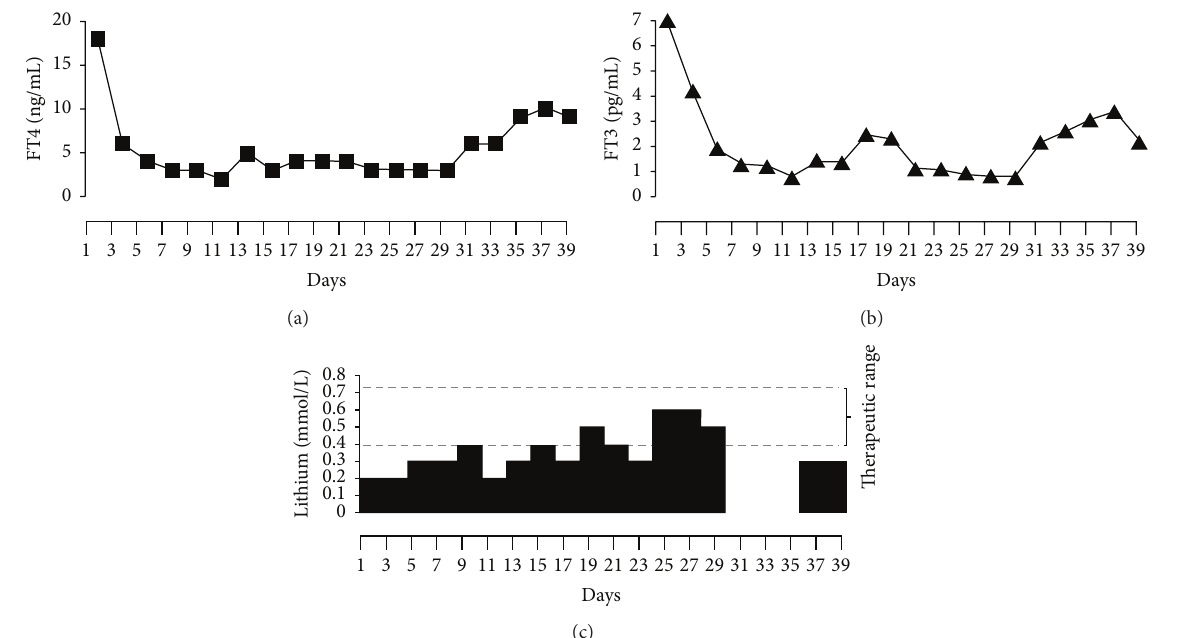
Figure 1: Correlation of free thyroid hormone levels and lithium levels over admission period. (a) shows the levels of free T4, followed by the levels of free T3 in (b), and corresponding lithium levels over the period of admission on (c). Note the low lithium level required to maintain euthyroid status over the entire course of hospital admission with no side